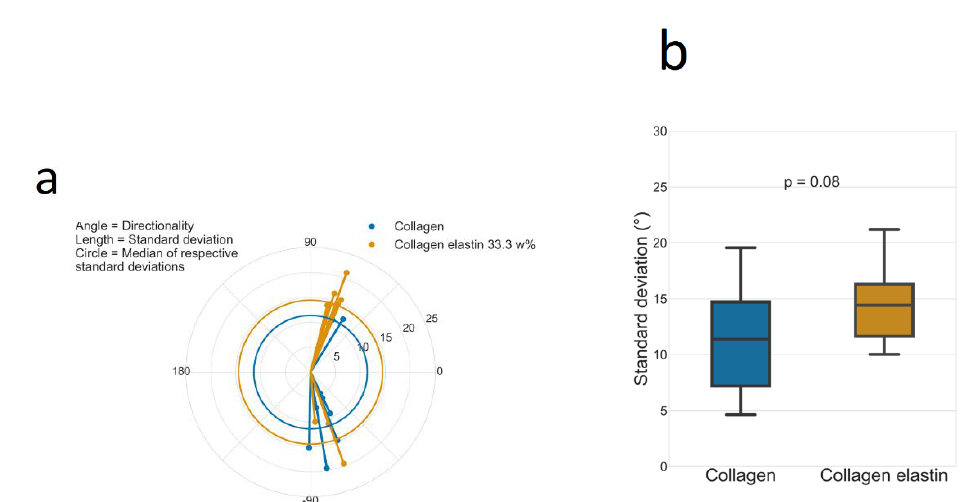
Figure 3. ( a ) Exemplary skeletonized image of a 2 mg/mL collagen network. ( b ): Angle distribution of ( a ). The degree values are given in the mathematical sense, i.e., 0° is pointing to the right. The fit is a Gaussian function, provided by ImageJ.